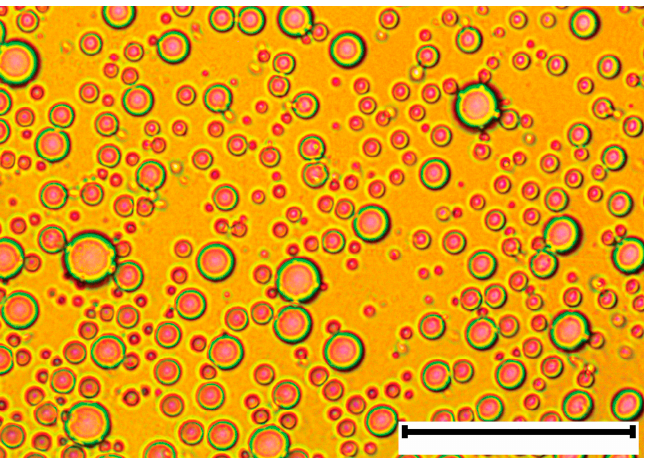
Figure 1. Fuel-water emulsion: microscope picture at 400× magnification; photo scale bar corre- sponds to 50 μ m (from research conducted by the authors).